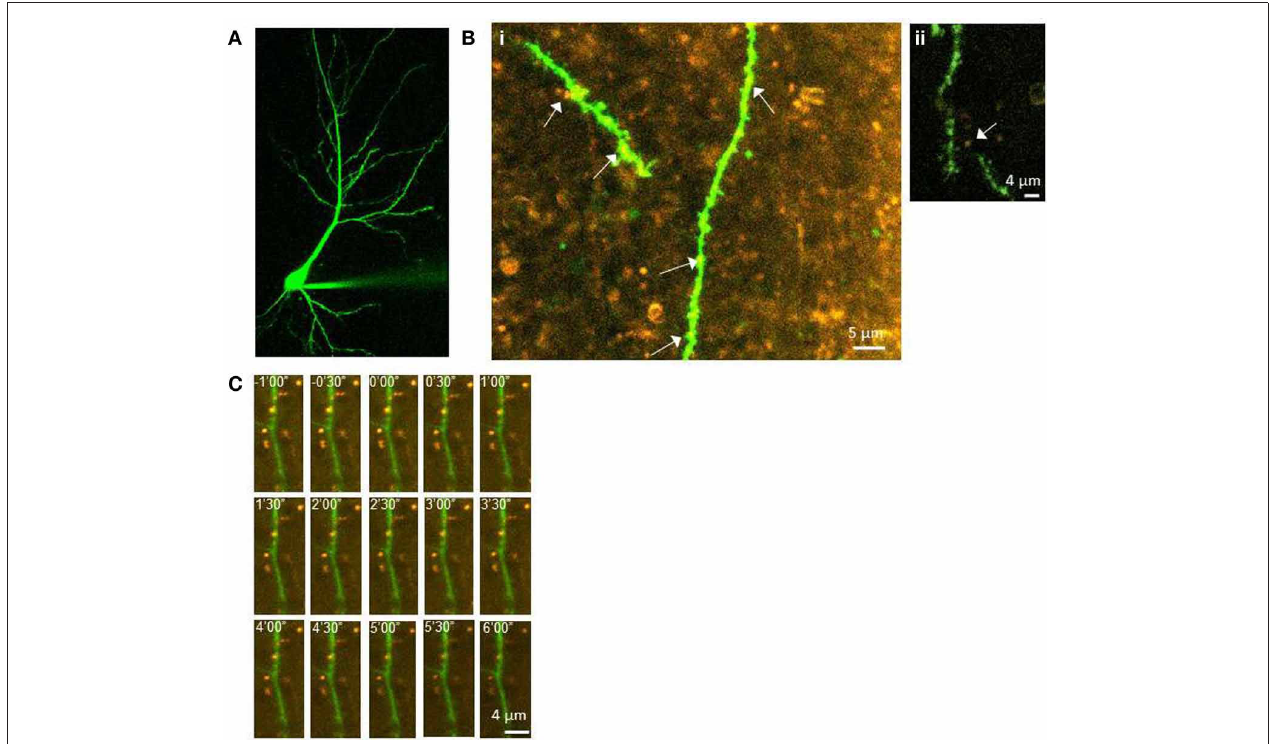
FIGURE 2 | Labeling of pre- and postsynaptic elements of CA3-CA1 synapses. (A) CA1 neuron filled with Alexa Fluor 488. (B) Examples of FM 1-43 loaded terminals (orange) in the same field of view as Alexa Fluor 488 filled CA1 dendritic branches (green). Arrows indicate putative contacts between terminals and spines/dendrites. The dendritic branch is approximately 140 μ m from